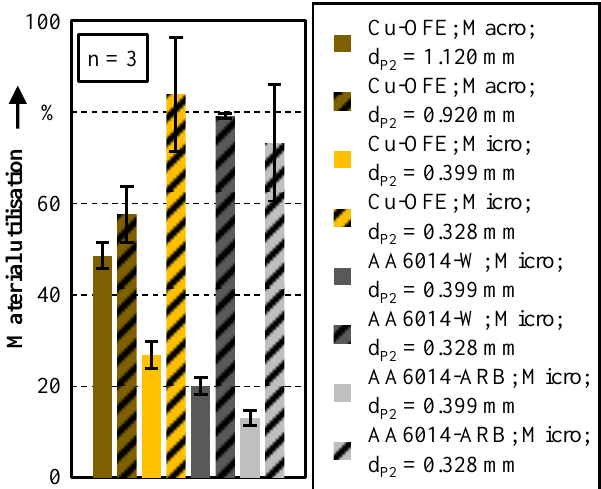
Figure 6. Material utilisation during extrusion stage 2.